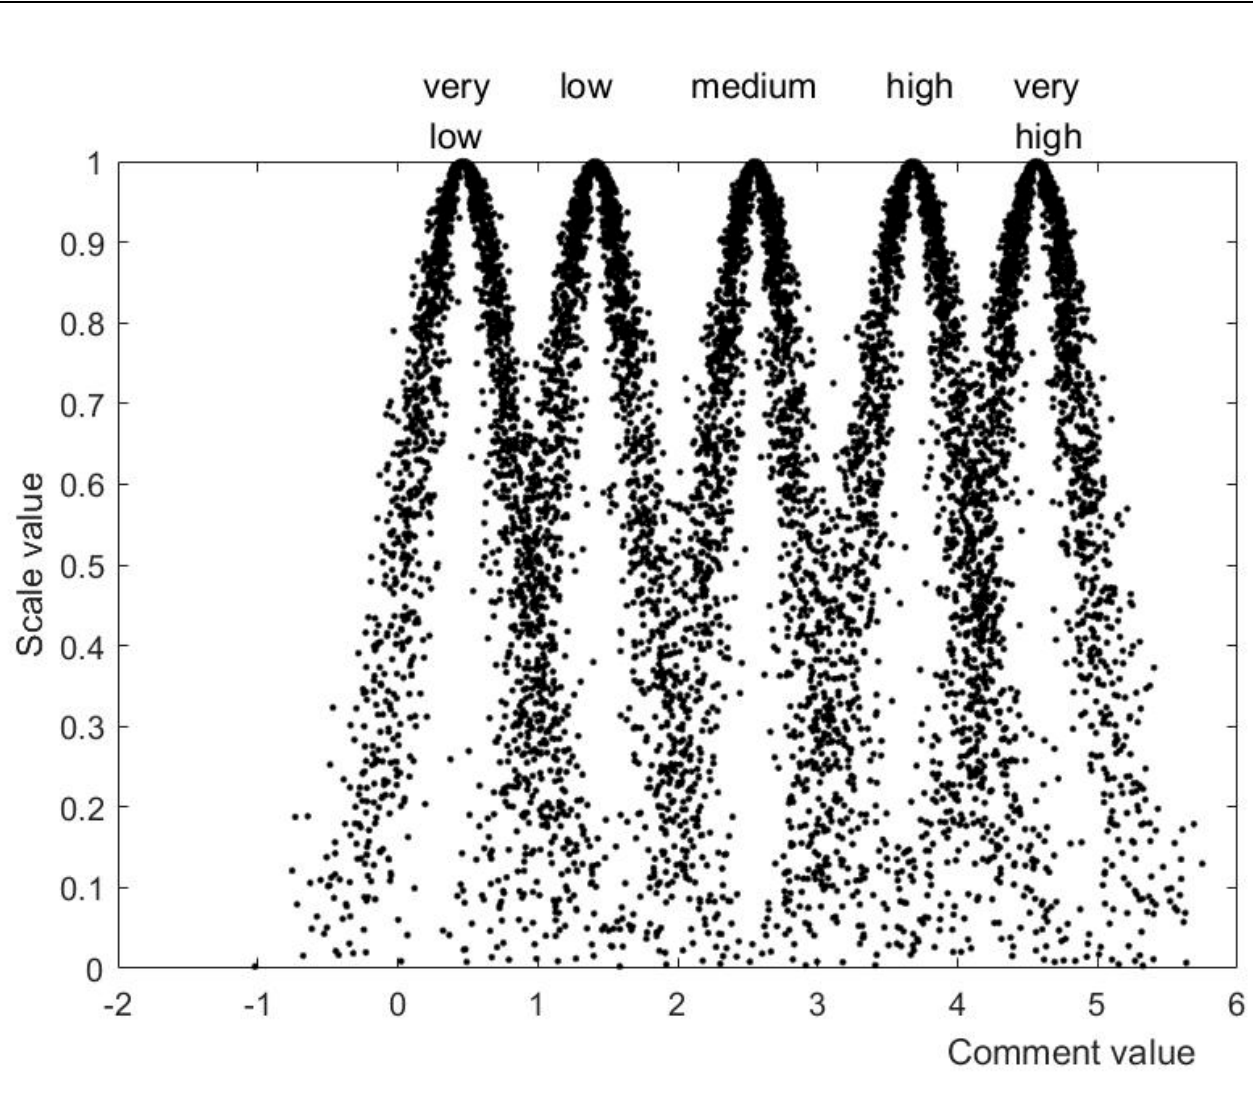
Figure 5. Cloud map of comment set.